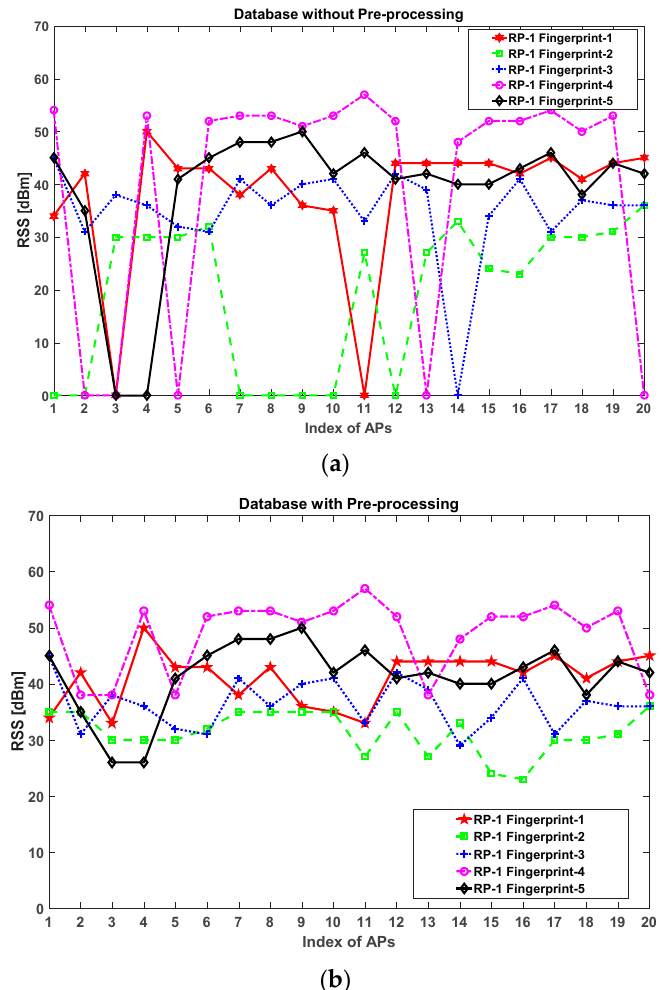
Table 2. Summary of simulation results.